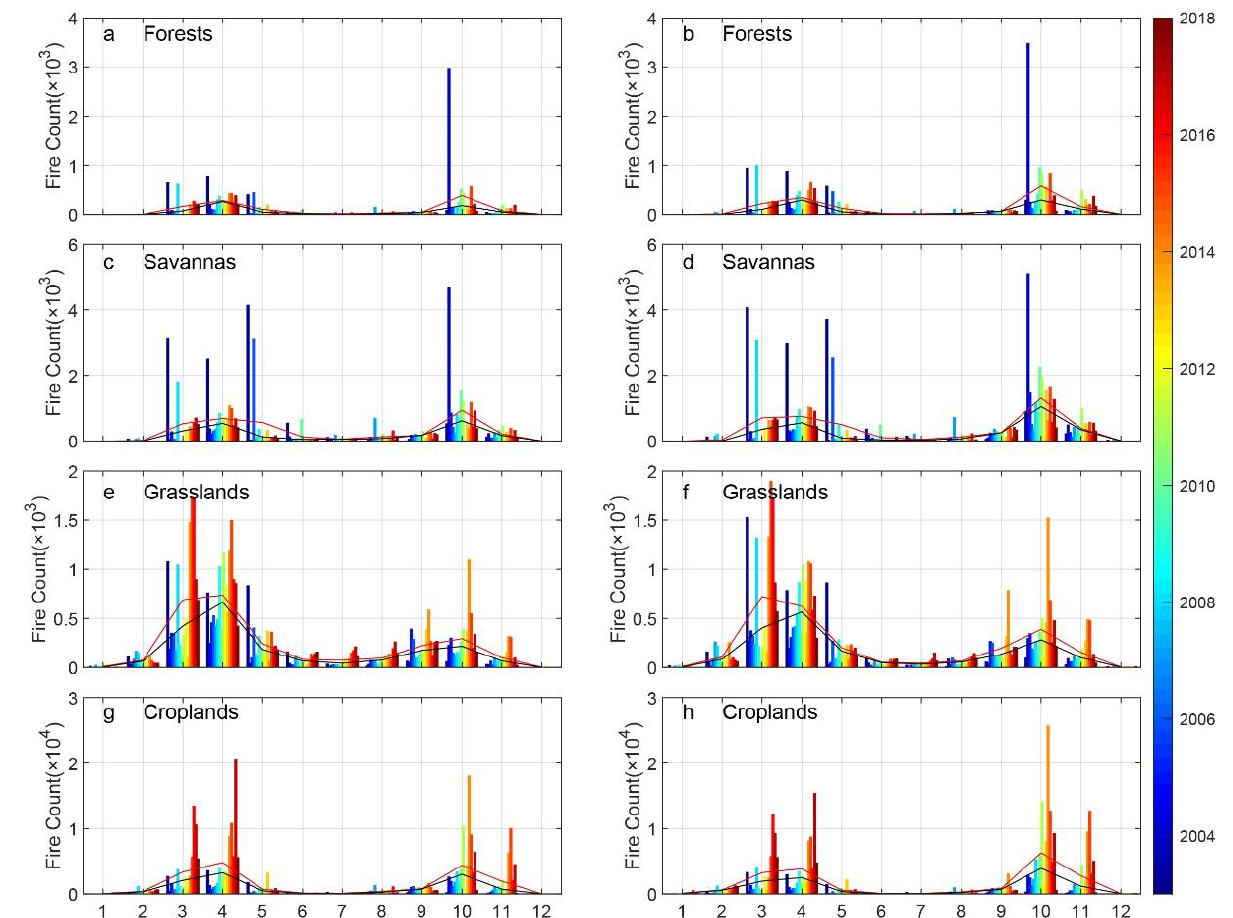
Figure 10. Monthly fire counts in different land cover types in northeastern China during 2003–2018 from ( left panel ) Terra and ( right panel ) Aqua fire products. The graphs show the values for ( a , b ) forests, ( c , d ) savannas, ( e , f ) grasslands, and ( g , h ) croplands. The red lines represent the monthly average values, and the black lines represent the median values.